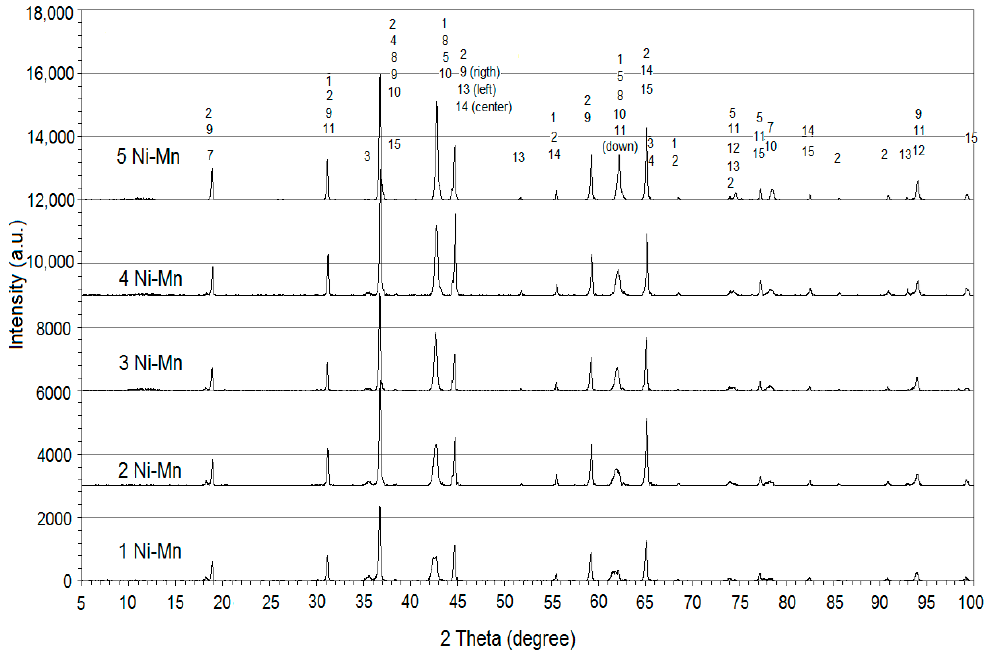
Figure 1. XRD patterns for Ni-Mn series of SHS catalysts. MgO—13.04%, Al 2 O 3 —23.48%, MgNO 3 —30.44%, KMnO 4 —4.34–21.04%, NiO—0–16.7%, Al—4%, Mg—8%. 1—MgAl 2 O 4 (orthorhombic), 2—MgAl 2 O 4 (cubic), 3—MnAl 2 O 4 (cubic), 4—MnAl 2 O 4 , 5—MgO (cubic), 6—Al 2 O 3 , 7—Mg 6 MnO 8 , 8—Mg 0,9 Mn 0,1 O, 9—NiAl 2 O 4 , 10—MgNiO 2 , 11—3MgO NiO, 12—MgO 3NiO.